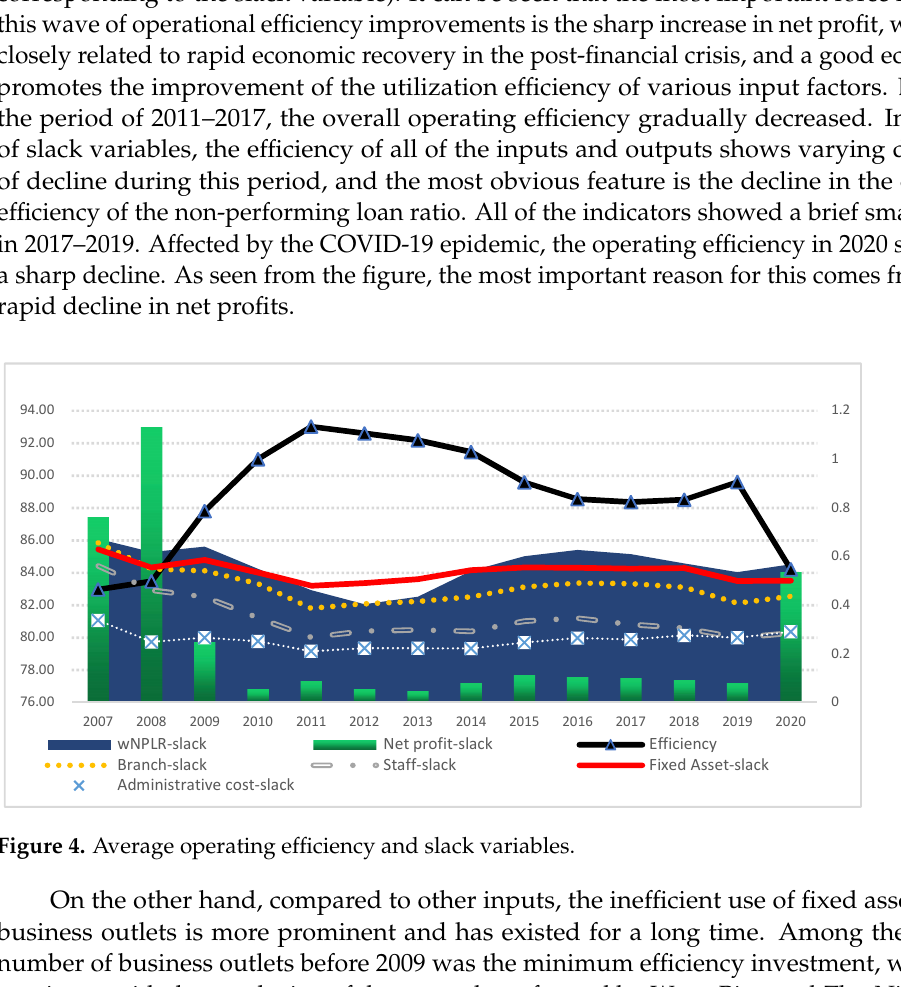
Figure 5. Operating efficiencies of the different types of commercial banks.